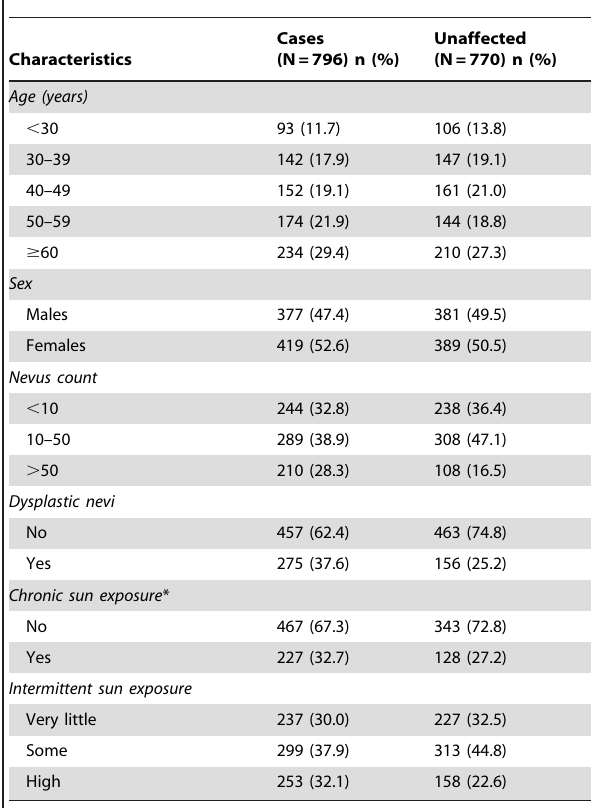
Table 1. Distribution of characteristics of study